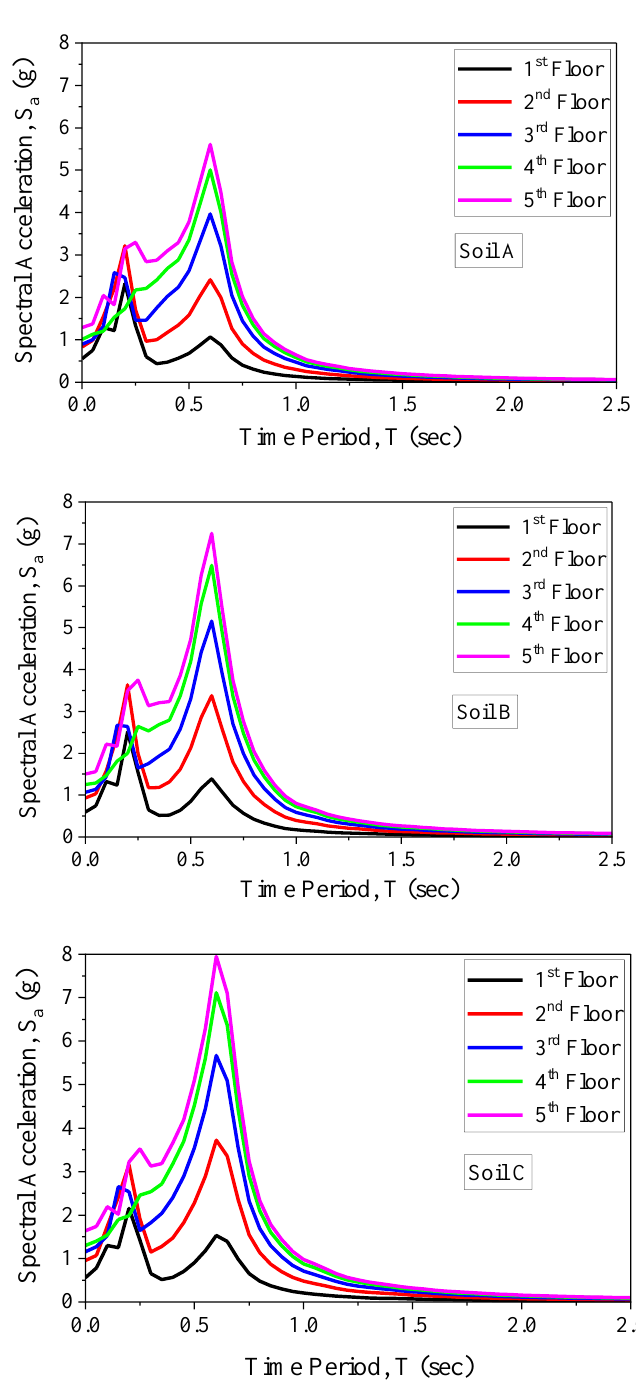
Figure 6. FRS of an irregular building for various soil types.